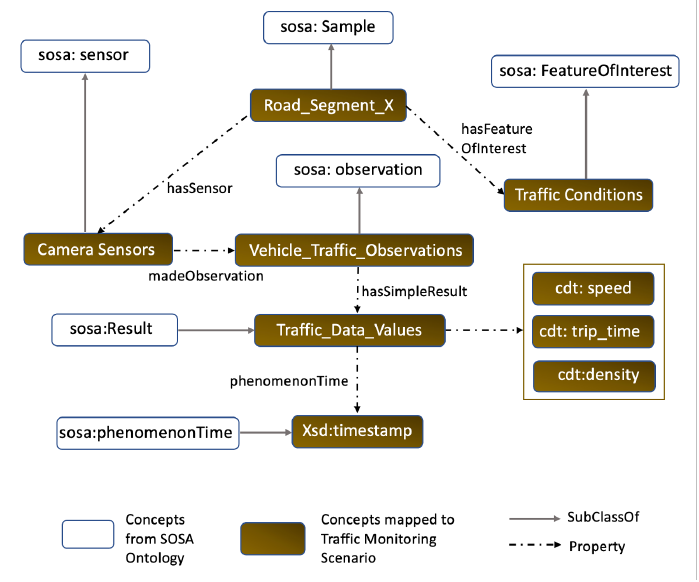
Figure 9. Illustration of the traffic sensor